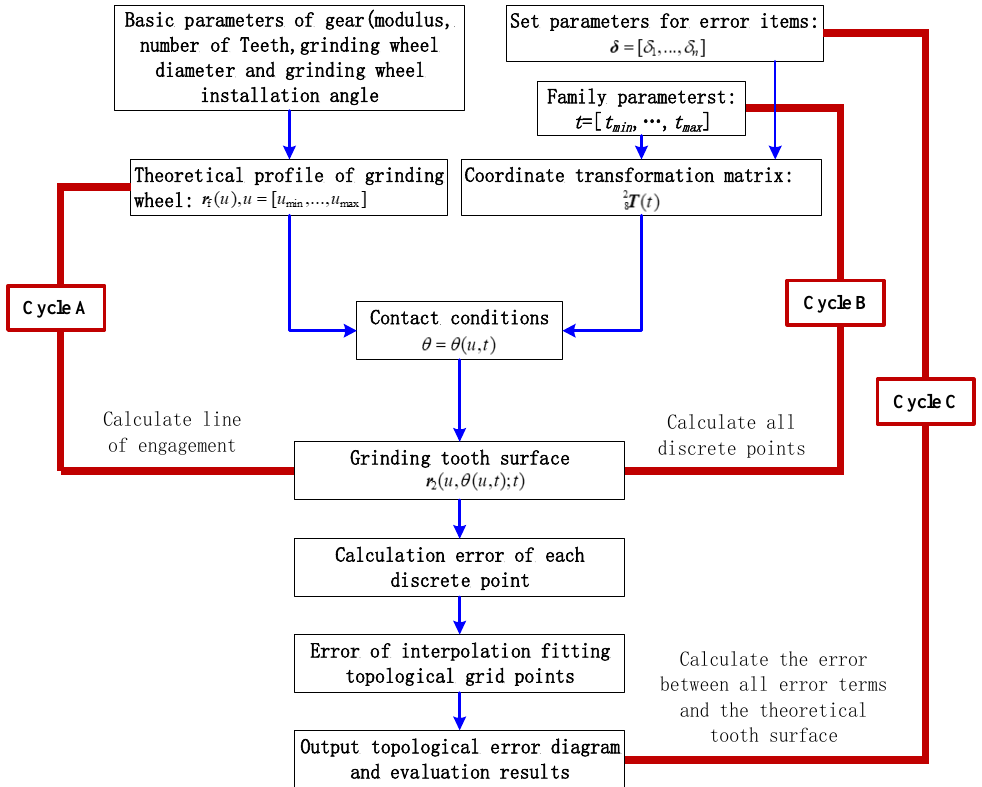
Figure 6. Evaluation flowchart of assembly errors and profile ground tooth surface deviations.